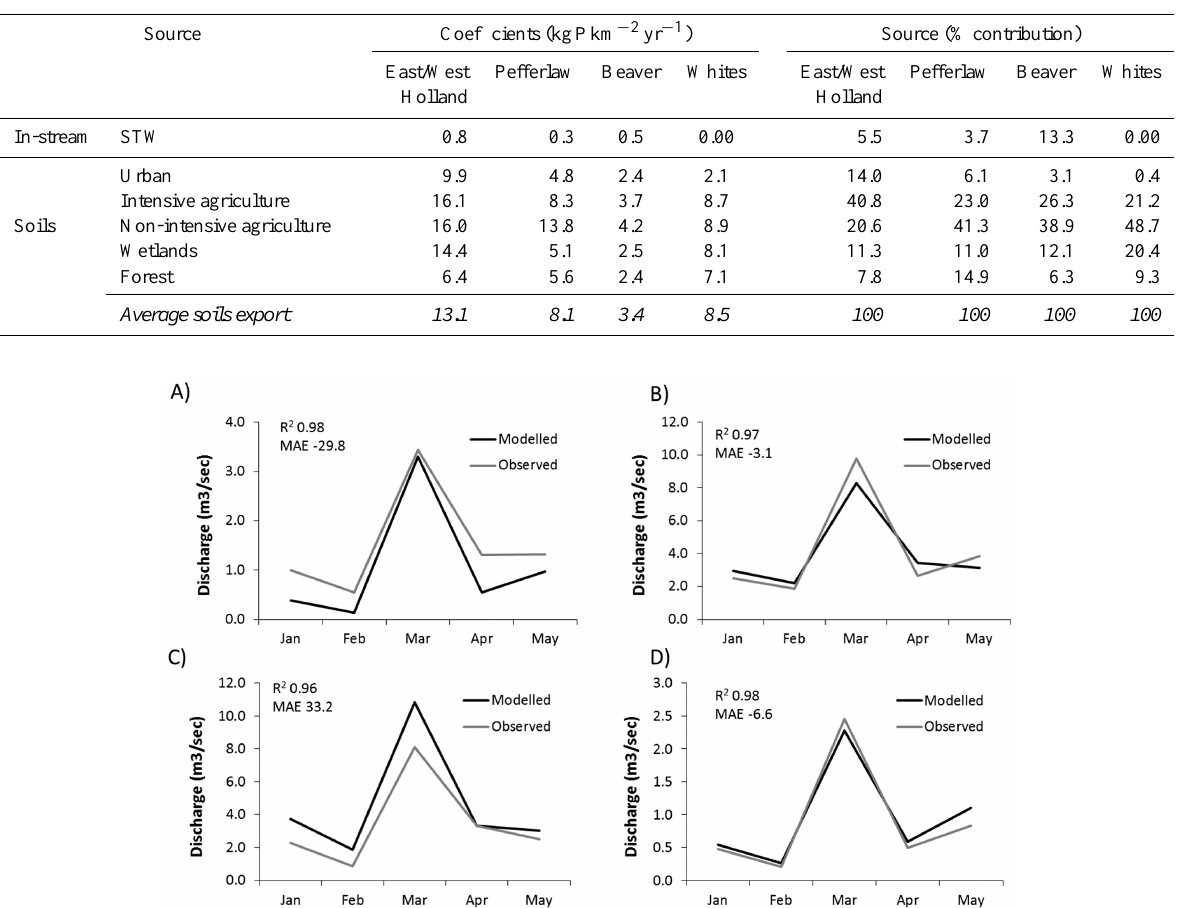
Figure 8. Analysis of model response to observed spring melt in (a) Holland, (b) Pefferlaw, (c) Beaver and (d) Whites catchments. Results analysed during spring melt of